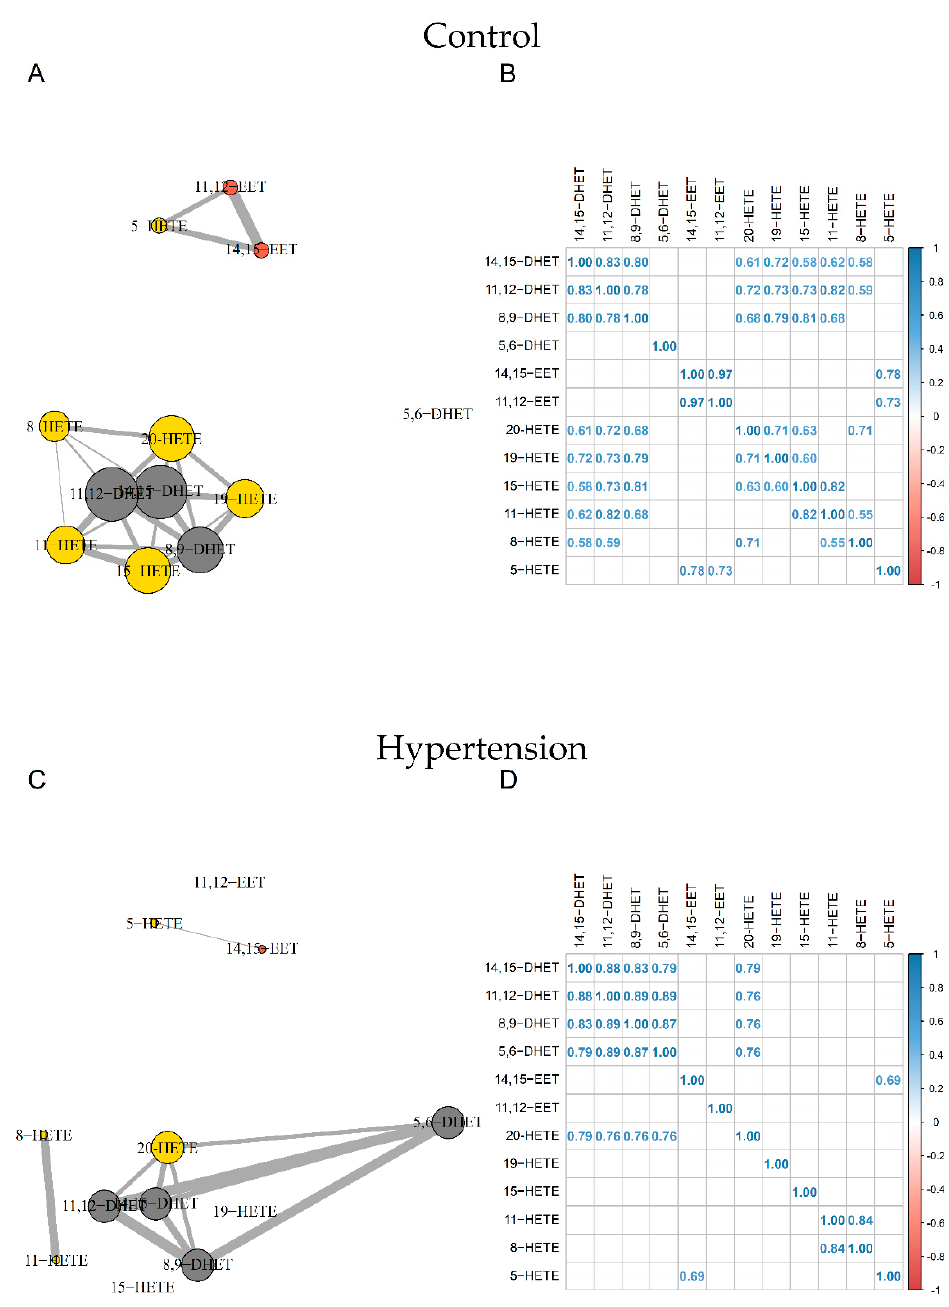
Figure 3. Correlation network and correlation matrix for Control group ( A , B ) and HTN ( C , D ). EETs, HETEs, and DHETs are shown in orange, yellow, and grey, respectively. Sizes of nodes and edges are proportional to the number of correlations and the strength of the correlation, respectively (n = 44). DHET: dihydroxyeicosatrienoic acid; EET: epoxyeicosatrienoic acid; HETE: hydroxyeicosatetraenoic acid; HTN: